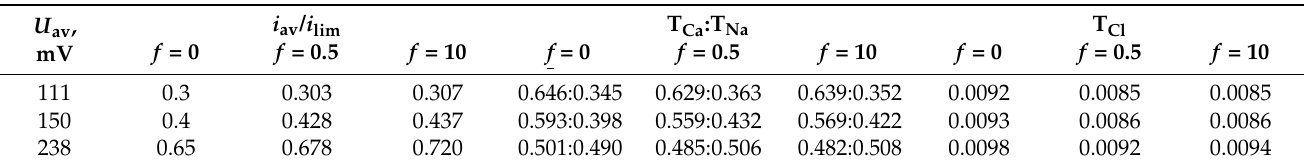
Table 3. Results of calculation of the average current density and transport numbers in the membrane in CC and PEF modes at different average voltages, U av , and different frequencies in Hz: f = 0 (CC mode), 0.5 and 10; α = 0.5.